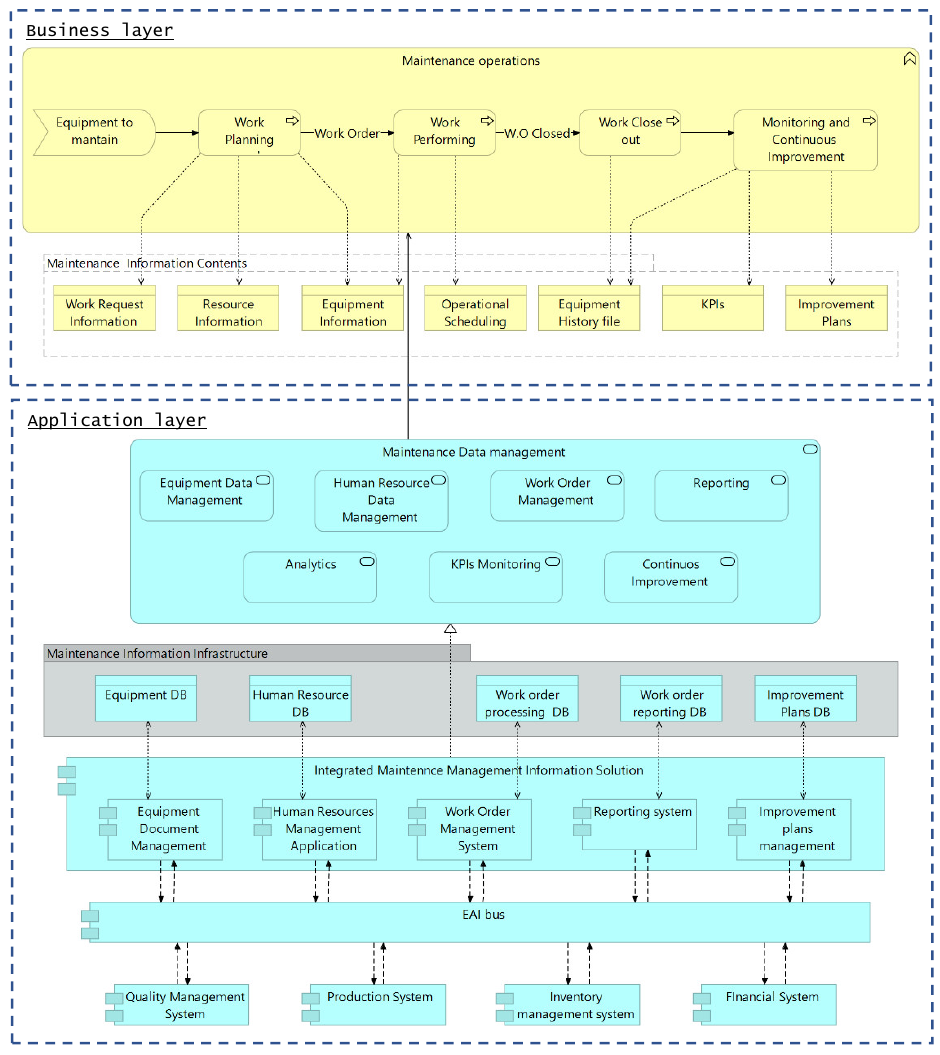
Figure 2. Maintenance process architecture.